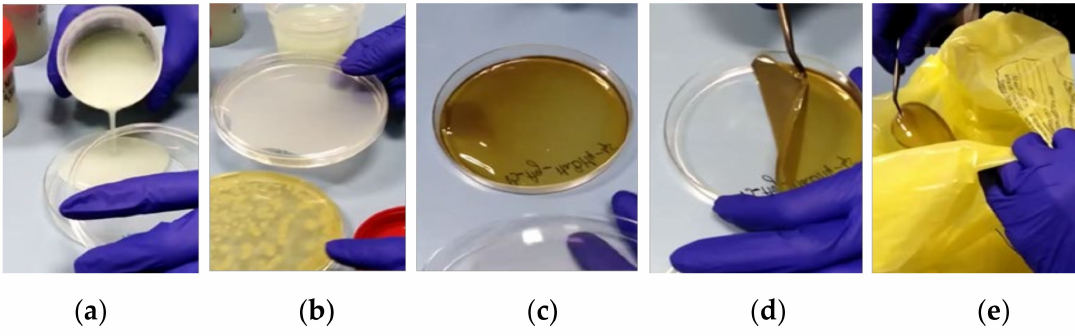
Figure 6. Decontamination using eco-friendly active nanocomposite peelable coatings: ( a ) decontamination solution, ( b ) decontamination solution is allowed to neutralize the contaminant, ( c ) dried peelable film, ( d ) peeling process and ( e ) decontamination waste.